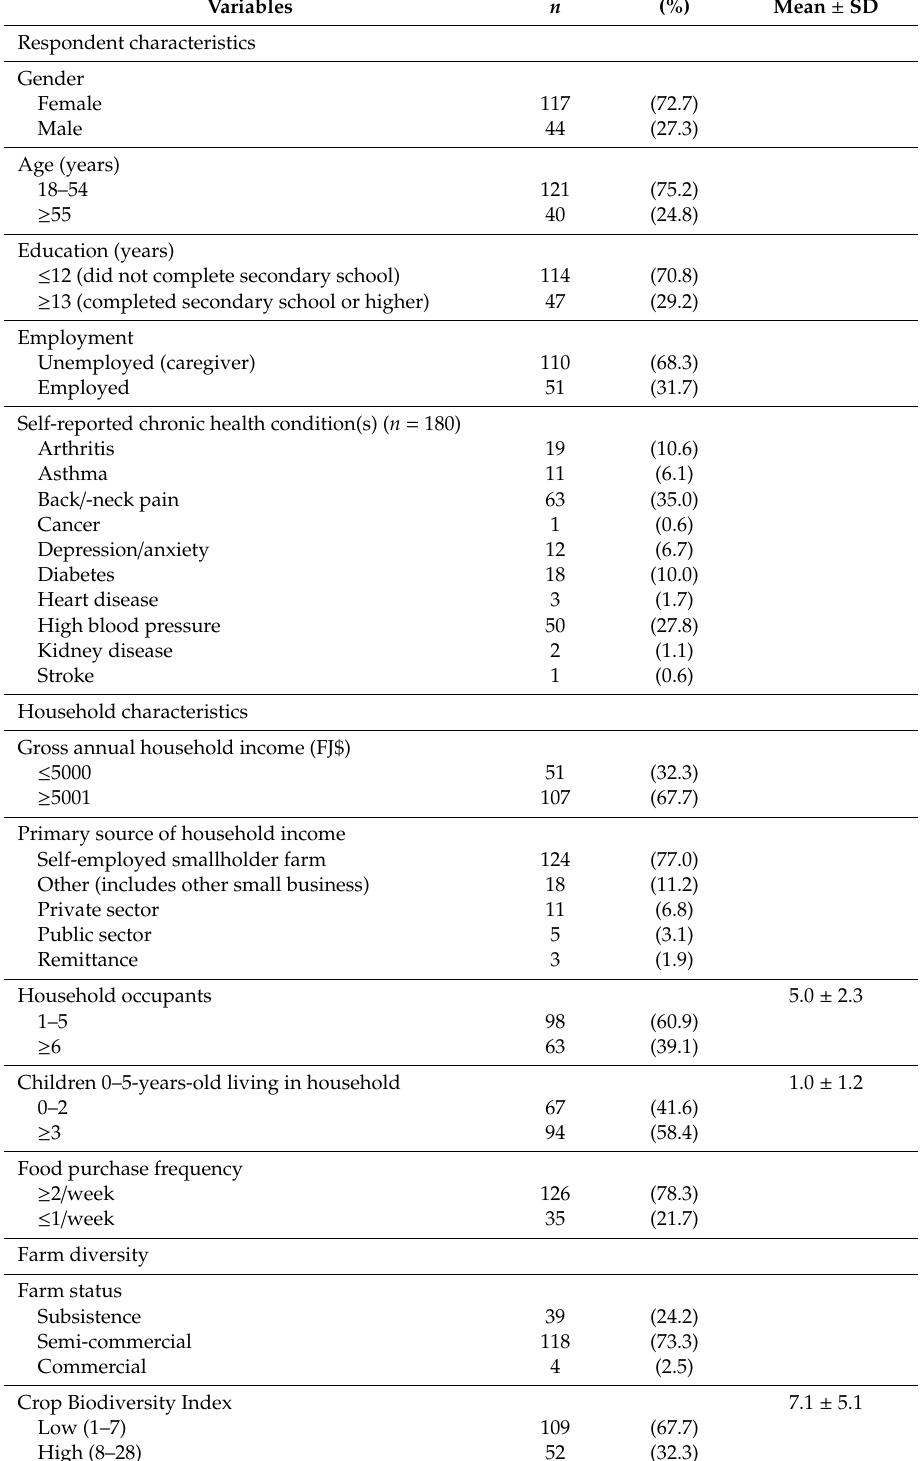
Table 1. Descriptive statistics for respondents, households, farm and household dietary diversity ( n =